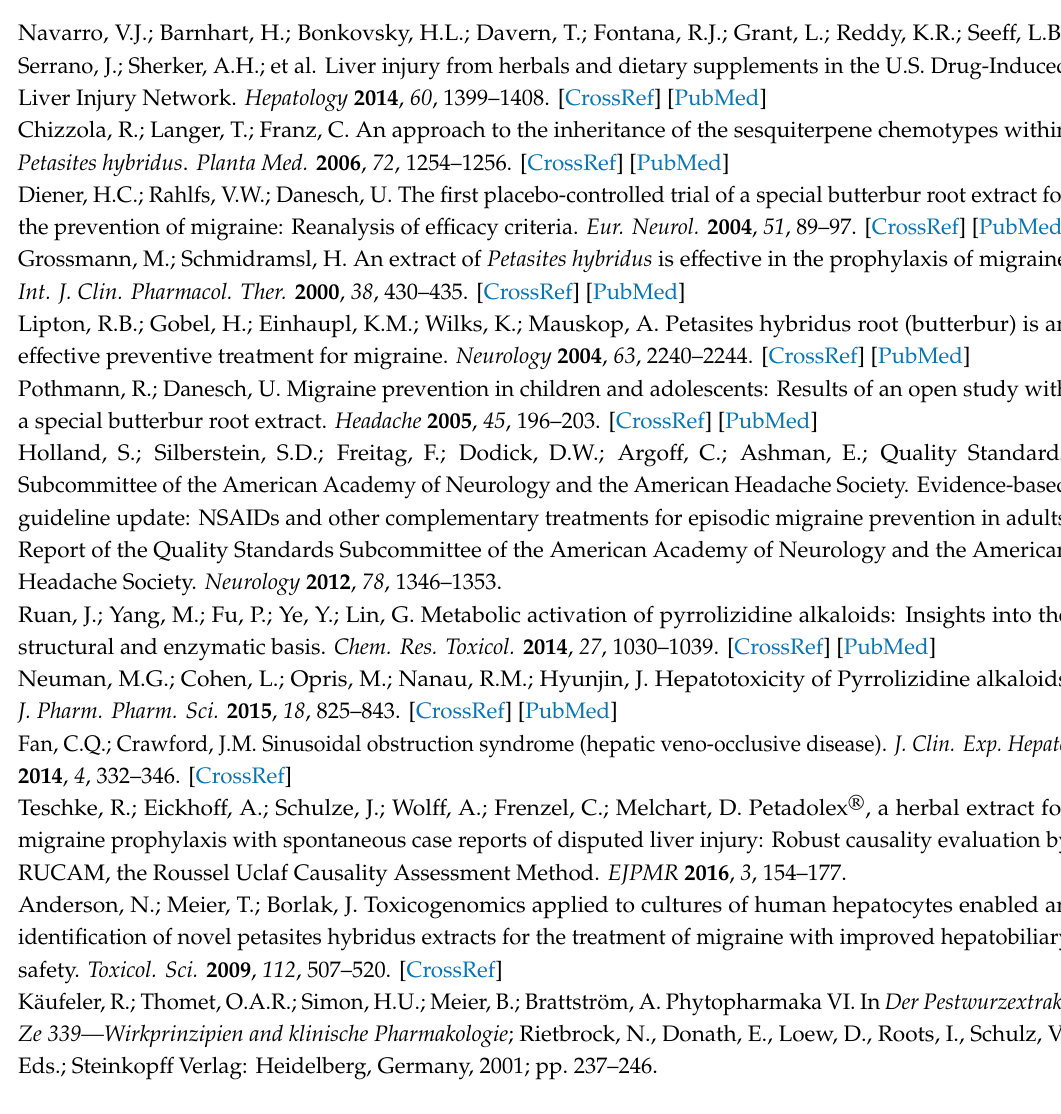
cultures, Table S2: Clinical biochemistry data and major histopathology findings after repeated oral dosing of rats with a Petasites hybridus extract for six